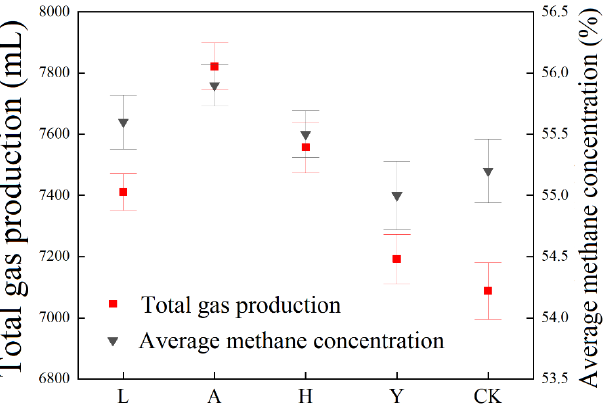
Figure 3. Effect of different inorganic passivators on gas production